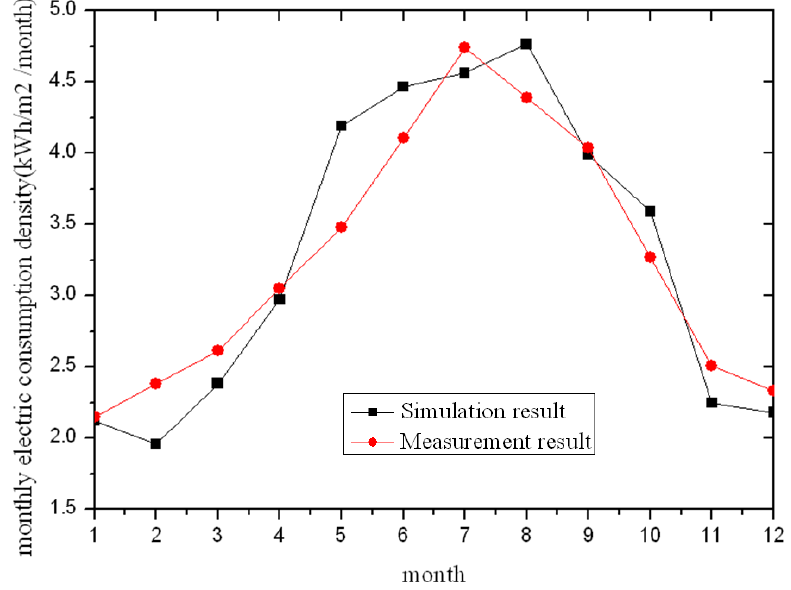
Figure 5. Comparison between the simulated and measured